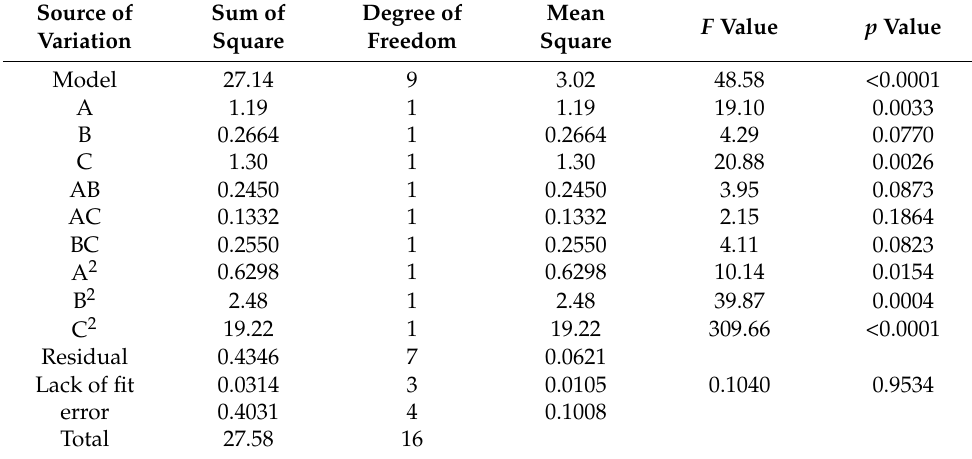
Table 4. Analysis of variance results (Loquat Pulp).